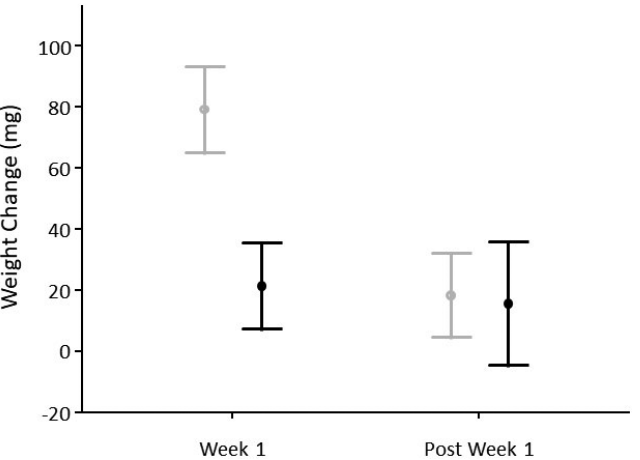
Fig. 3. Mean (±SE) size of embryos laid during: the first week fol- lowing treatment (Week 1), and the subsequent weeks following treatment (Post Week 1) of females who experienced either low- (grey symbols) or high- (black symbols) quality calling song.